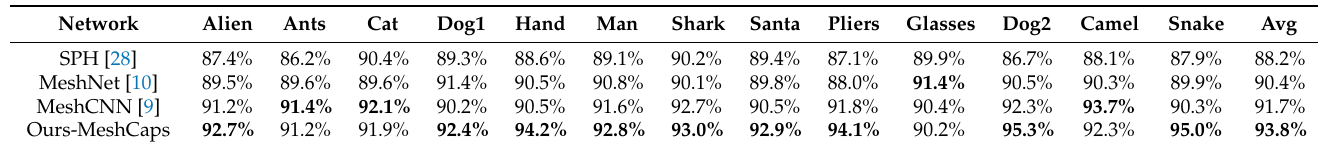
Table 1. SHREC15.